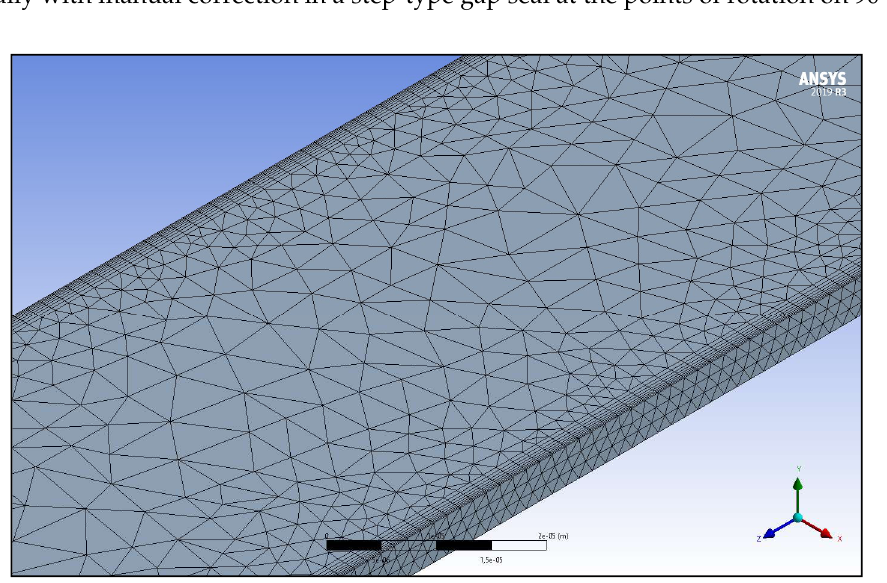
Figure 4. Simplified smooth slot channel geometry with constant sector gap.